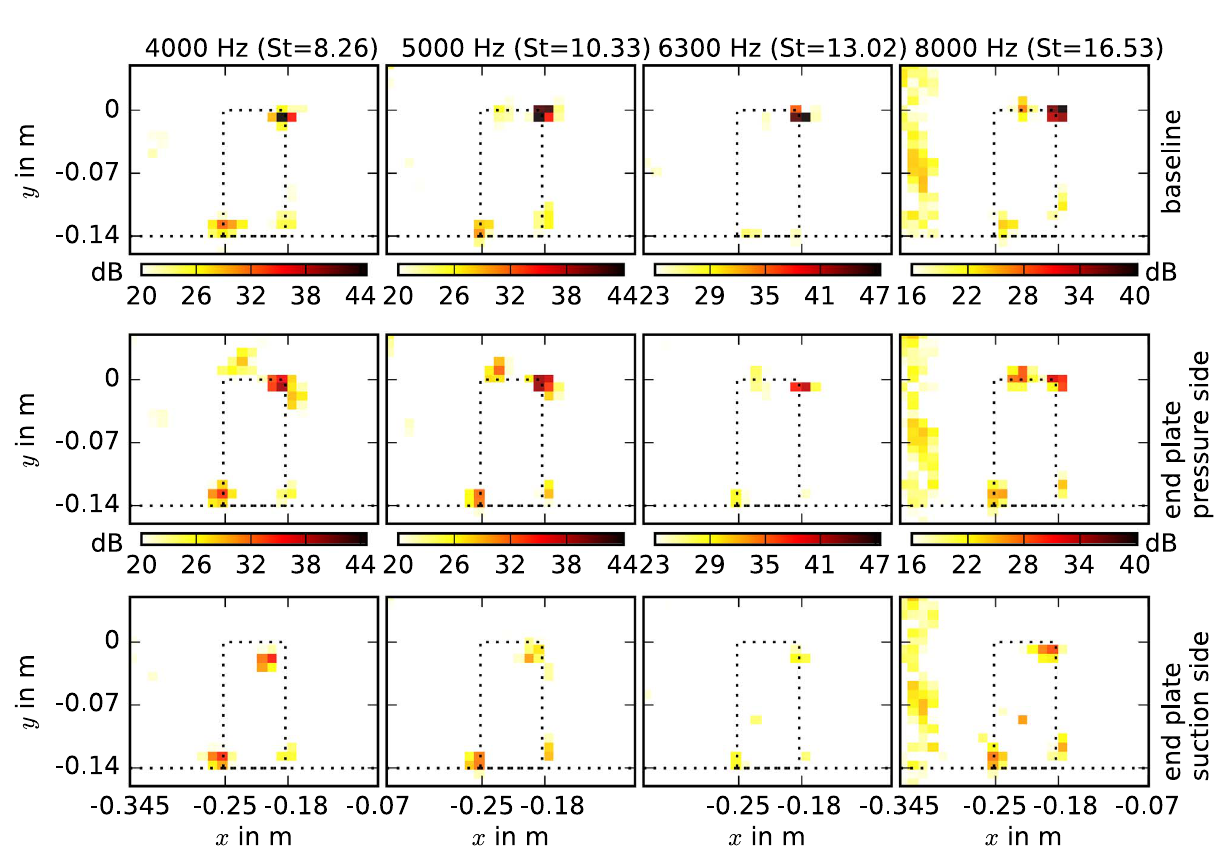
Figure 5. Third octave sound maps obtained at Re = 150,000 and 15 (cid:1) angle of attack, top baseline con fi guration, middle end plate pressure side, bottom end plate suction side, fl ow from left to right, black dotted line represents airfoil and wall, view on the suction